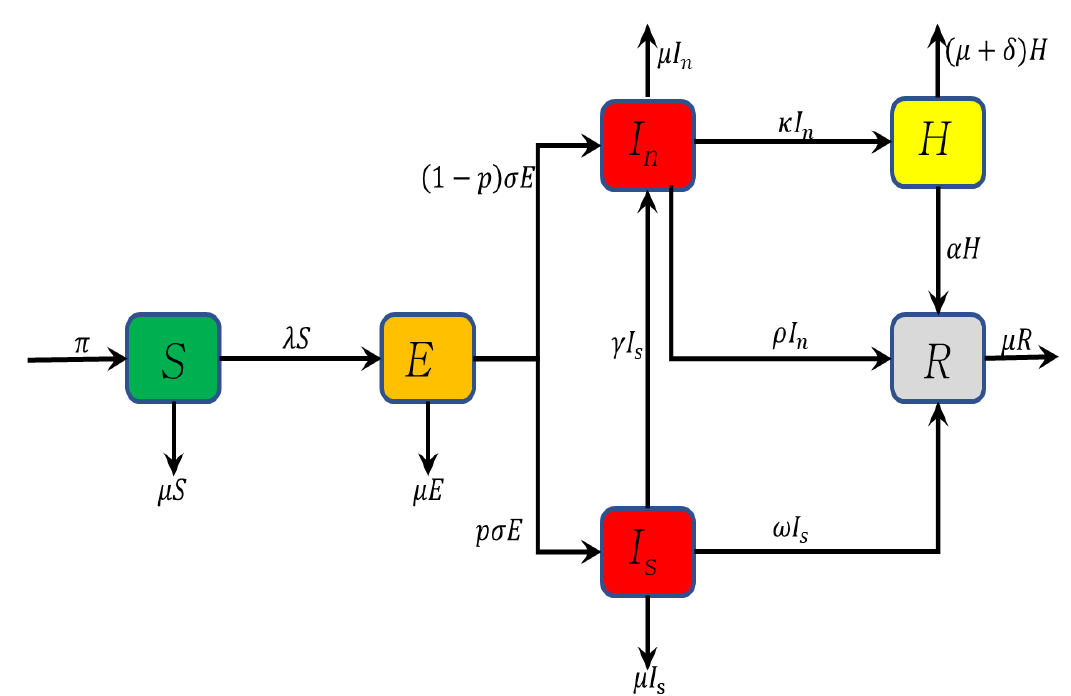
Figure 1. A model flow diagram for COVID-19 infection dynamics. The diagram shows the flow of individuals from one compartment to the other as their infection status with respect to the disease